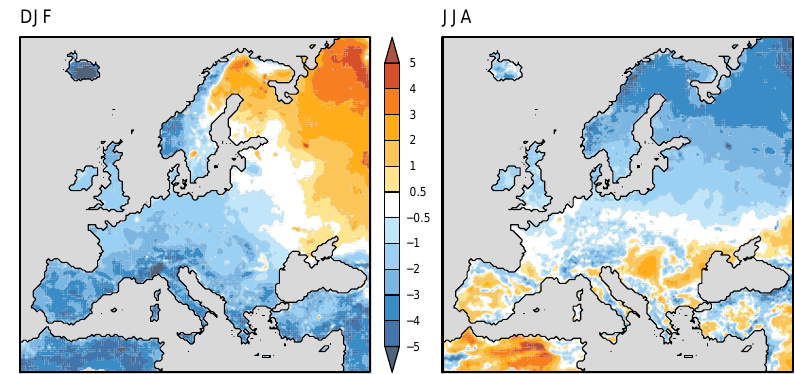
Figure 2. Spatial BIAS of near-surface air temperature (K) over the sample I K14 for DJF (left) and JJA (right) for RMIB-UGent-11. Compare to Fig. 2 of Kotlarski et al.